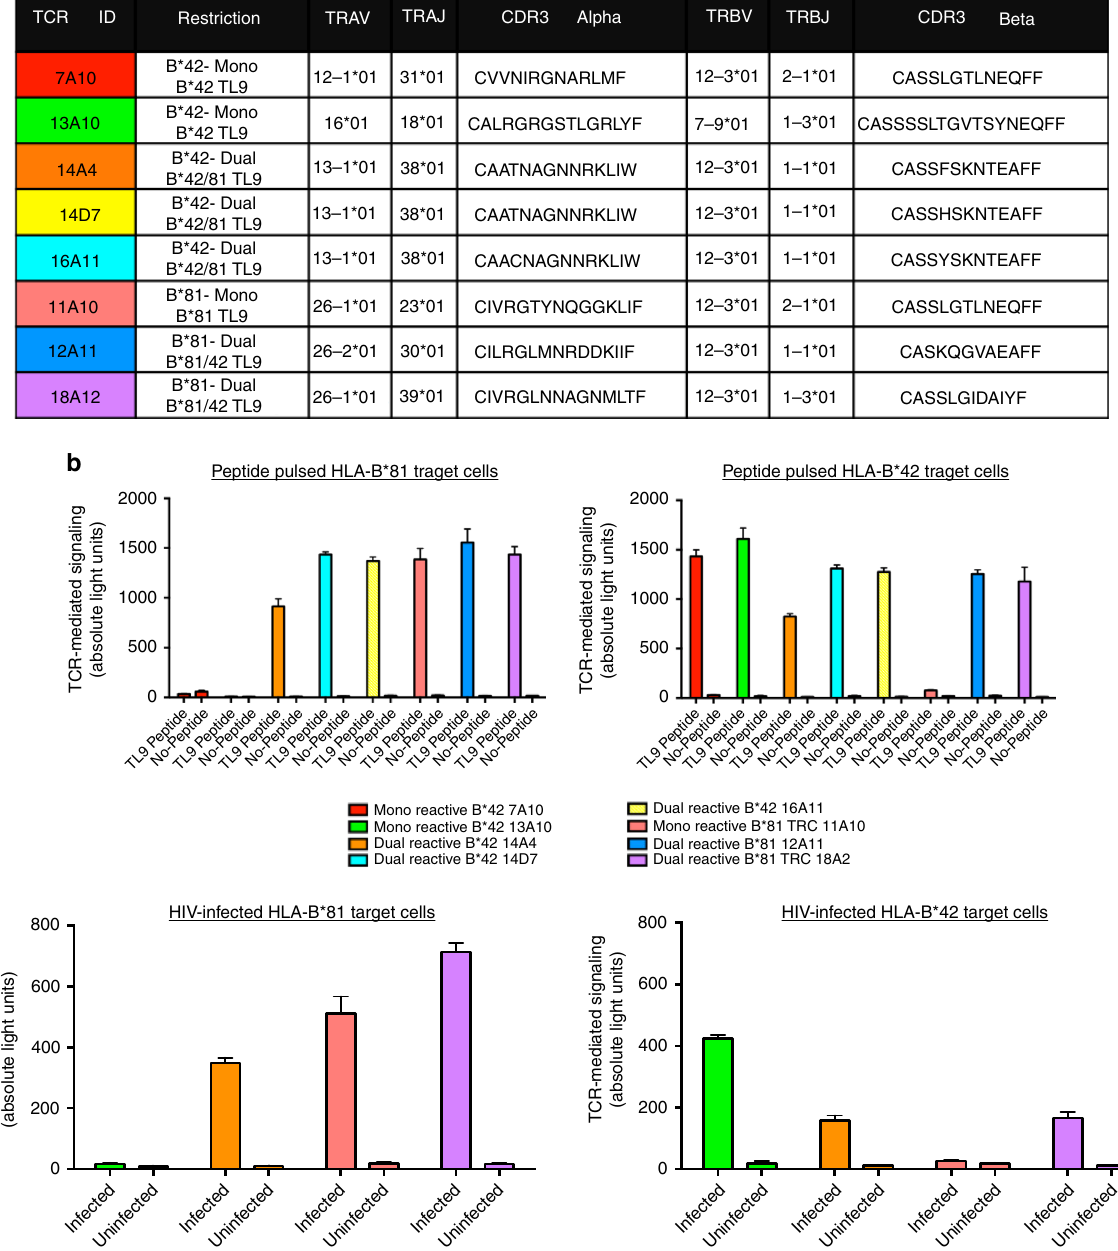
18A2. In contrast, the fi ve TCR clones isolated from B*42:01 expressing individuals displayed more disparate cross-recognition pro fi les, which was re fl ected by pair-wise Spearman R-values between 0.12 and 0.67. Notable differences were observed among B*42:01-derived TCR clones for recognition of TL9 peptide var- iants at positions 3 and 7, which are discussed below. To further